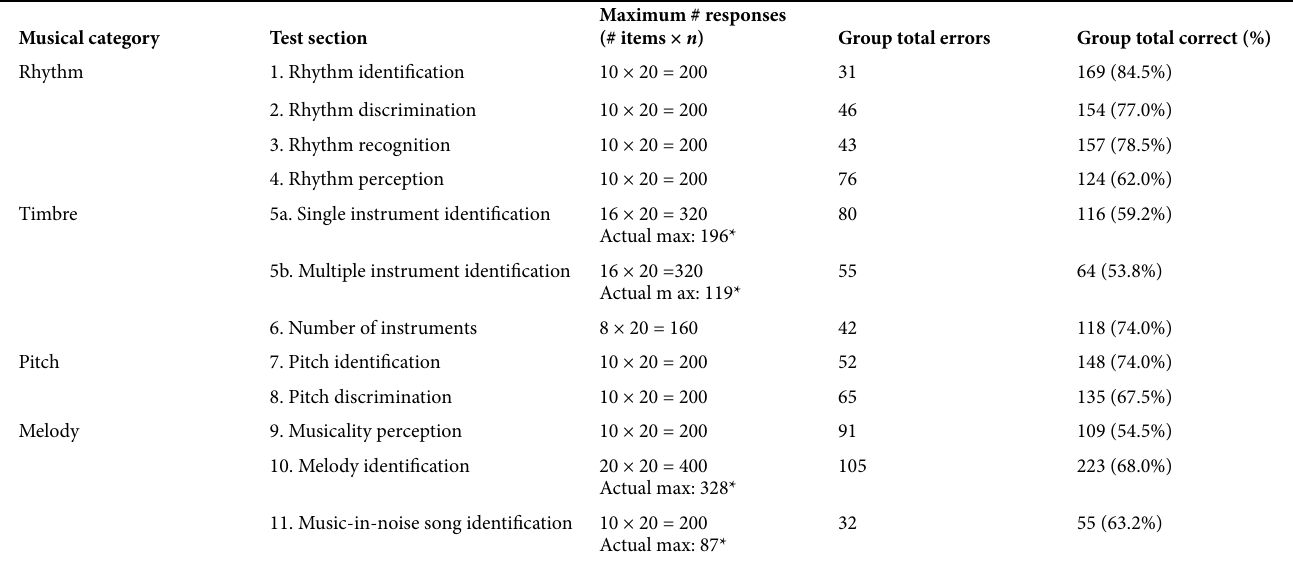
Table VIII. Error rates and percentage correct for the adapted version of the MPT presented to participants with hearing aids ( n =20) Musical